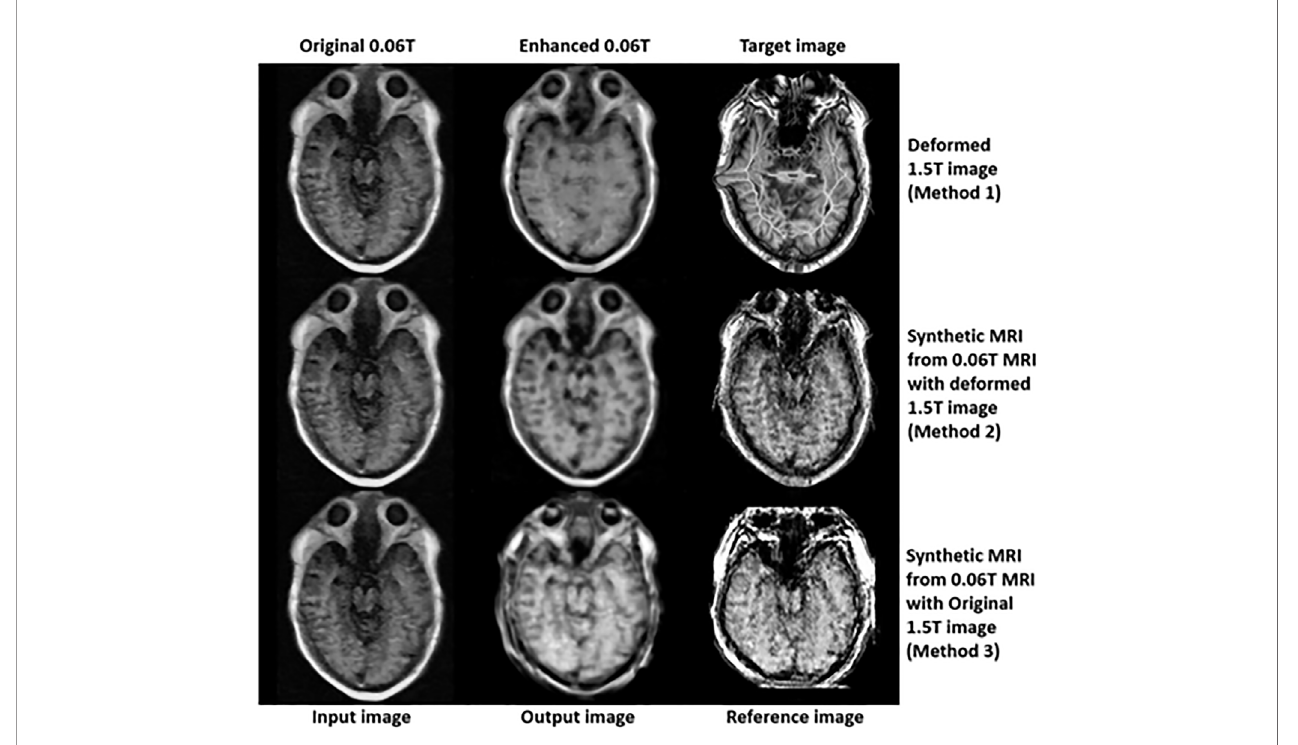
FIGURE 10 | Results of enhanced MRI of slice no. 10 in step 3 (conventional-GAN